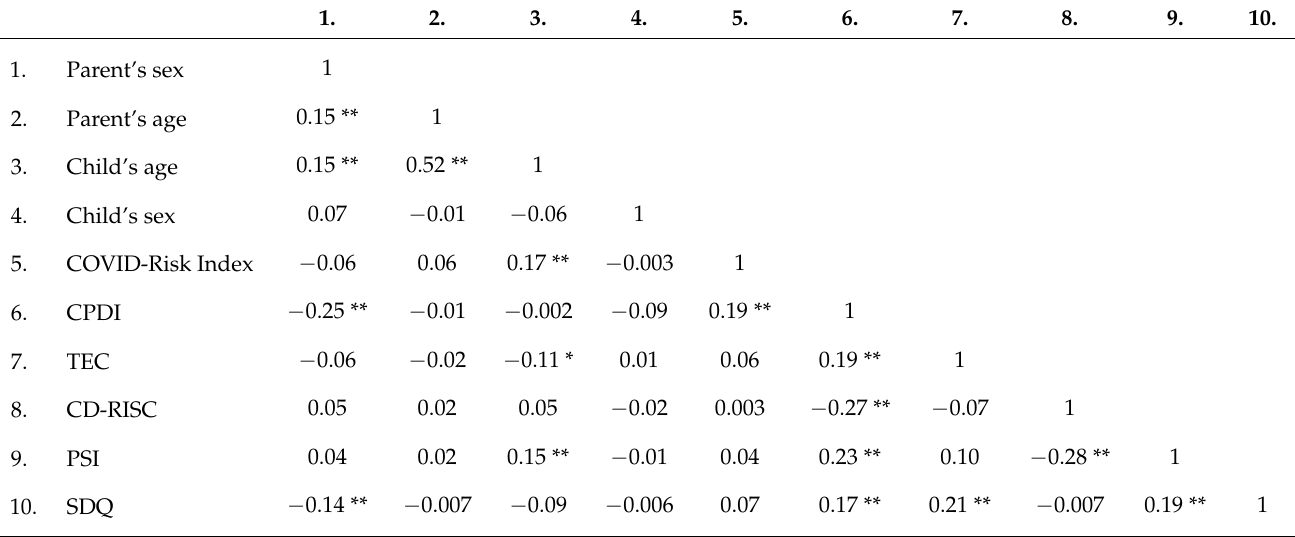
Table 1. Pearson correlation coefficients between the starting theoretical model variables.